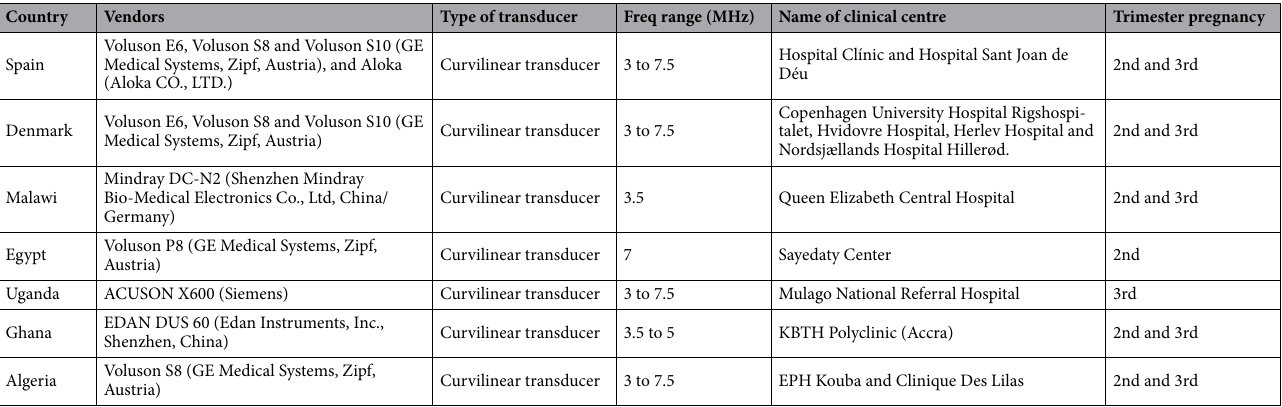
Table 1. Details about the seven datasets considered in the